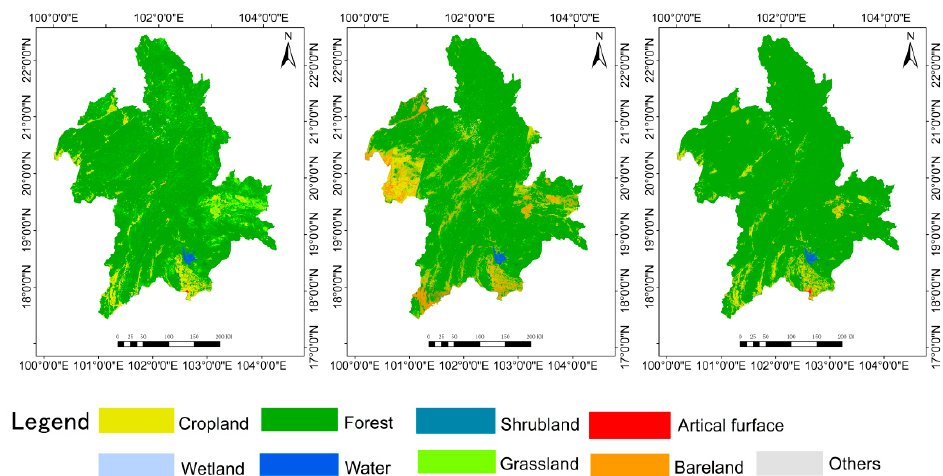
Figure 2. Three land cover products of the study area. The data from left to right are Globeland30-2010, FROM-GLC2010, and SERVIR MEKONG2010. Table 2. The original classification systems of the three land cover datasets, along with the relevant codes.